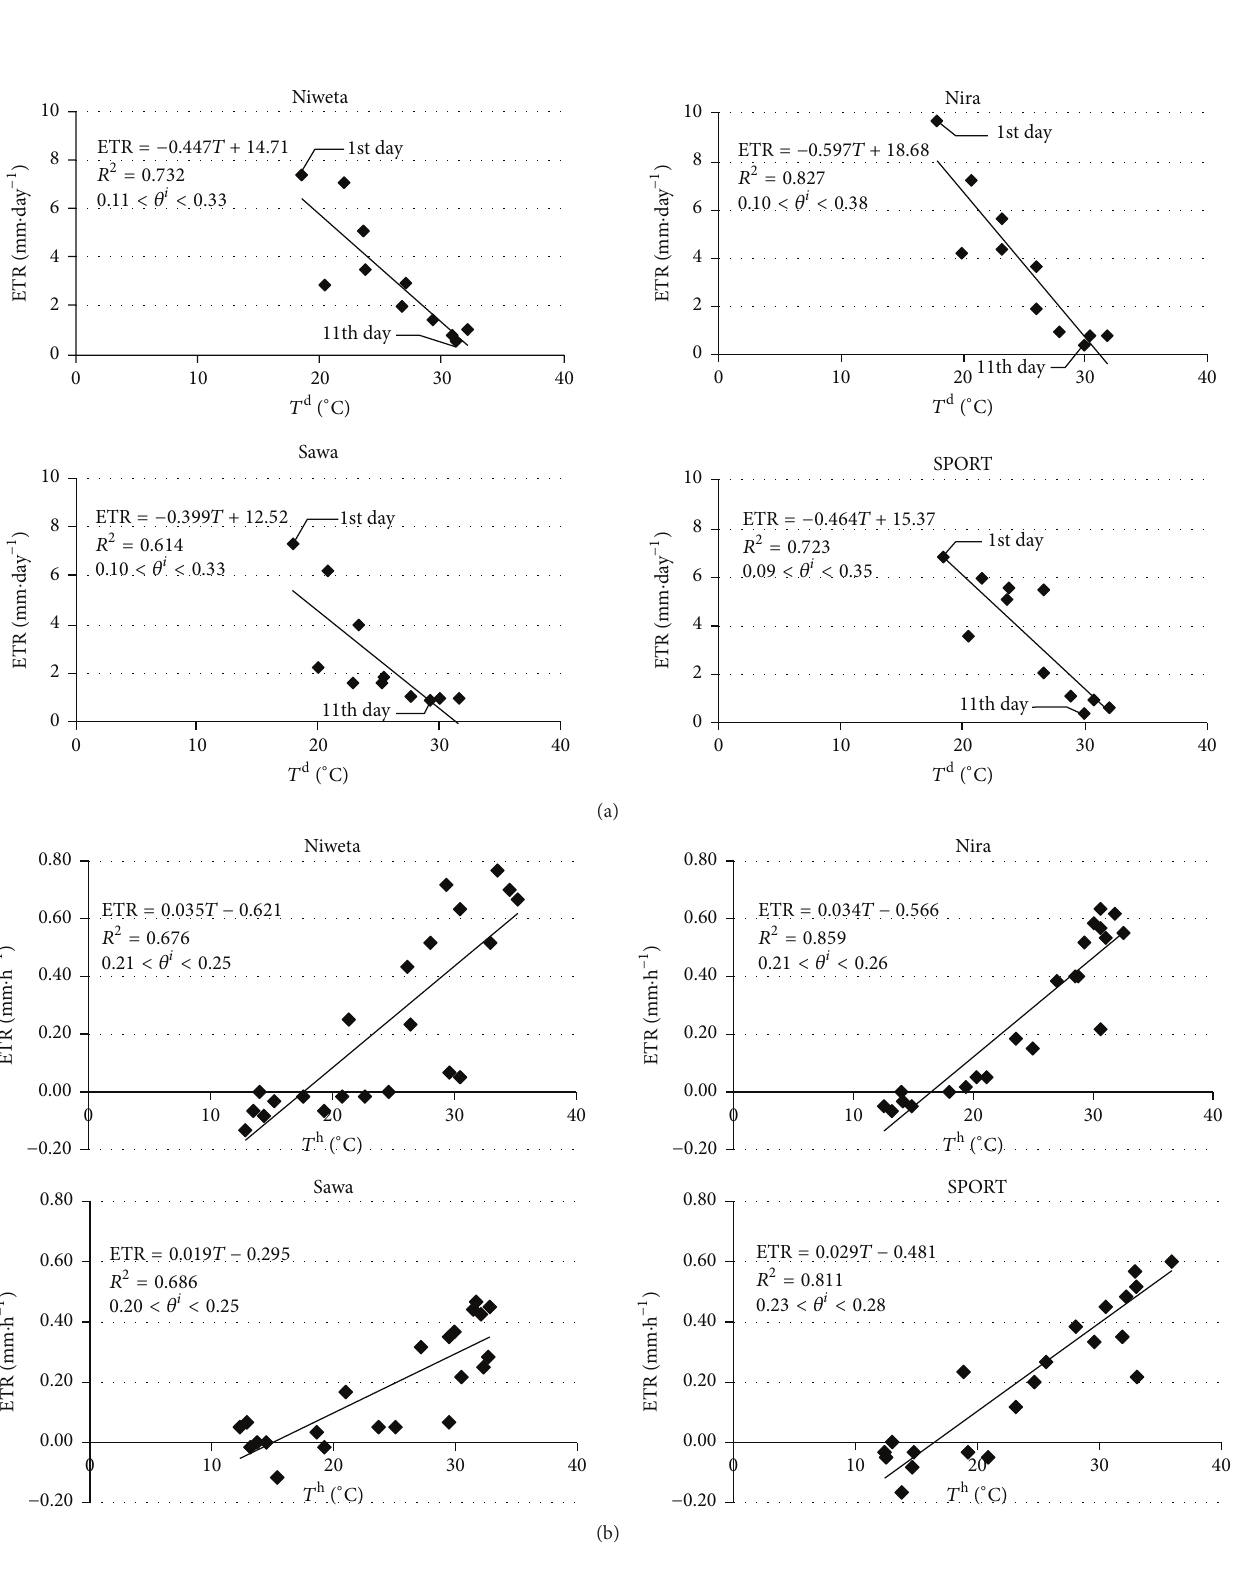
Figure 6: Relation of evapotranspiration to soil temperature at the depth of 2.5 cm. ETR is evapotranspiration, 𝑇 d ( h ) is mean diurnal (hour) temperature of soil at the depth of 2.5 cm, and 𝜃 d 𝑖 (𝜃 h 𝑖 ) is initial moisture for day